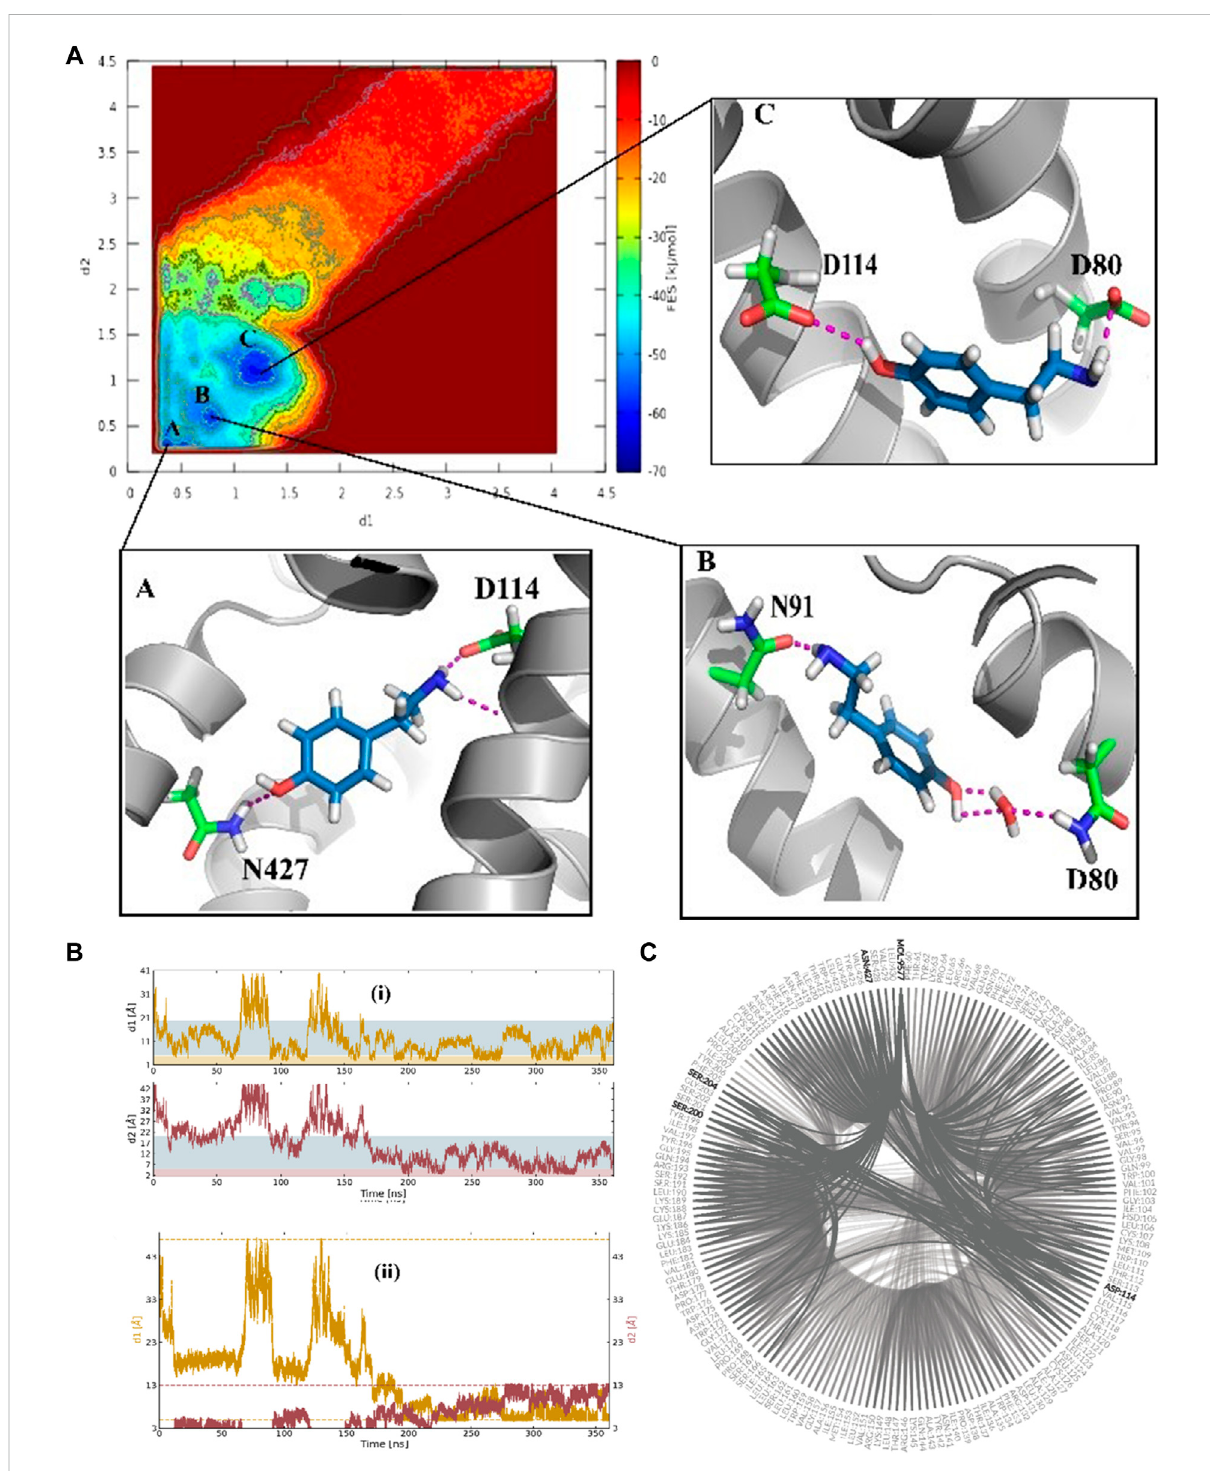
FIGURE 3 (A) The binding energy surface (BFES) of TyrR/TA system showing the location of basins A, B, and C. The binding modes corresponding to each basinarealsodepicted toshowthekeyresiduesinvolved inthebindingofTAtoitsreceptor. (B) Timeevolutionofbinding/unbinding processduring theFM simulation with (i) separate and (ii) amalgamating formsof CVs. The unbound, precomplex,and binding states in(i) are colored as white, blue, and orange, respectively. The recrossing events between bound and unbound states are shown in plot (ii) as a function of simulation time. (C) The hydrogen-bonding network (HBN) plot highlighting the key residues during the FM simulation of the TA/TyrR